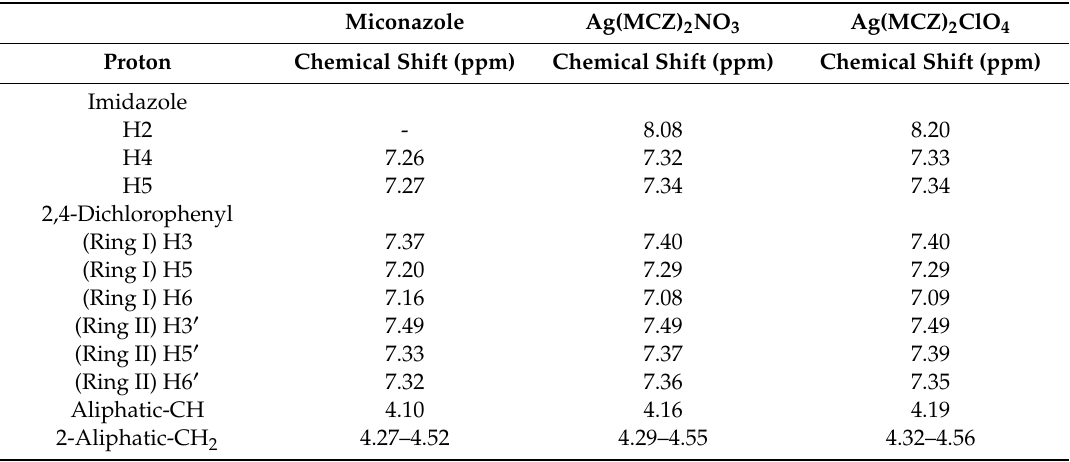
Table 1. Proton chemical shifts in ppm for miconazole and complex compounds at room temperature in CDCl 3